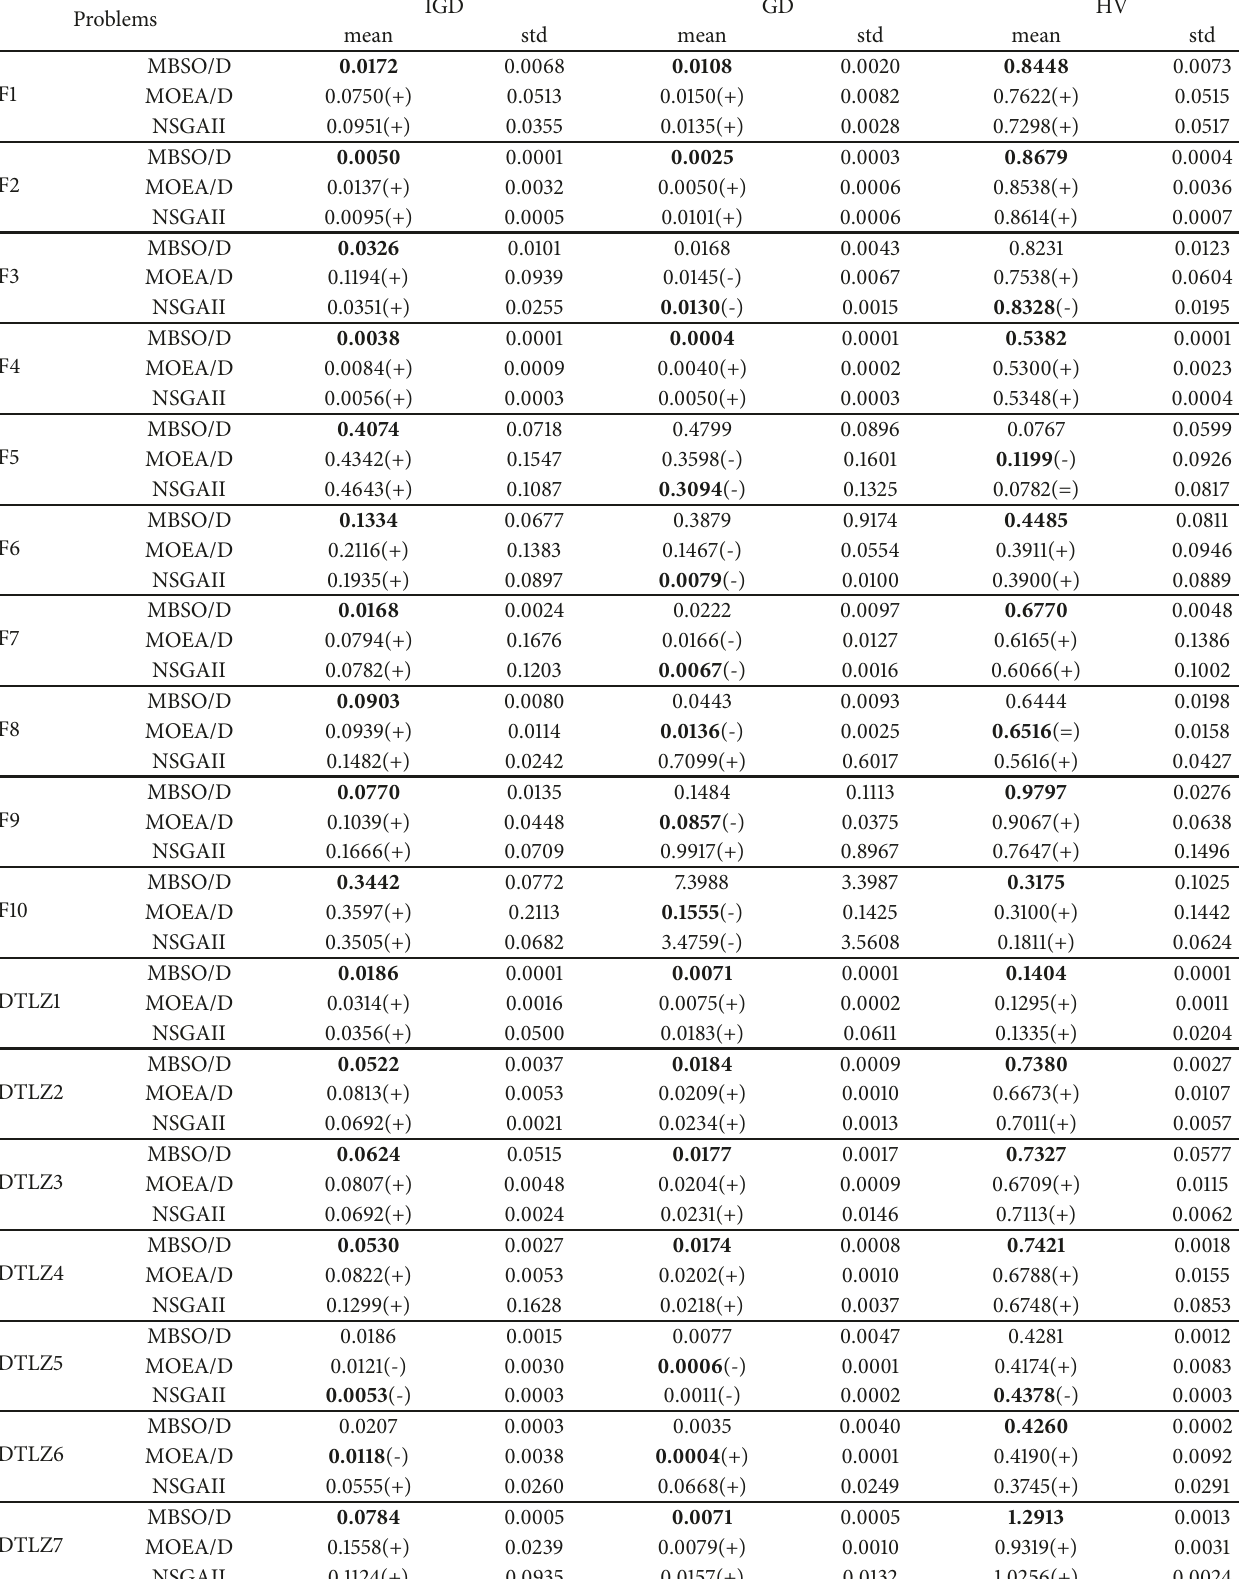
Table 1: IGD, GD, and HV obtained by IMOEA/DA, MOEA/D, and